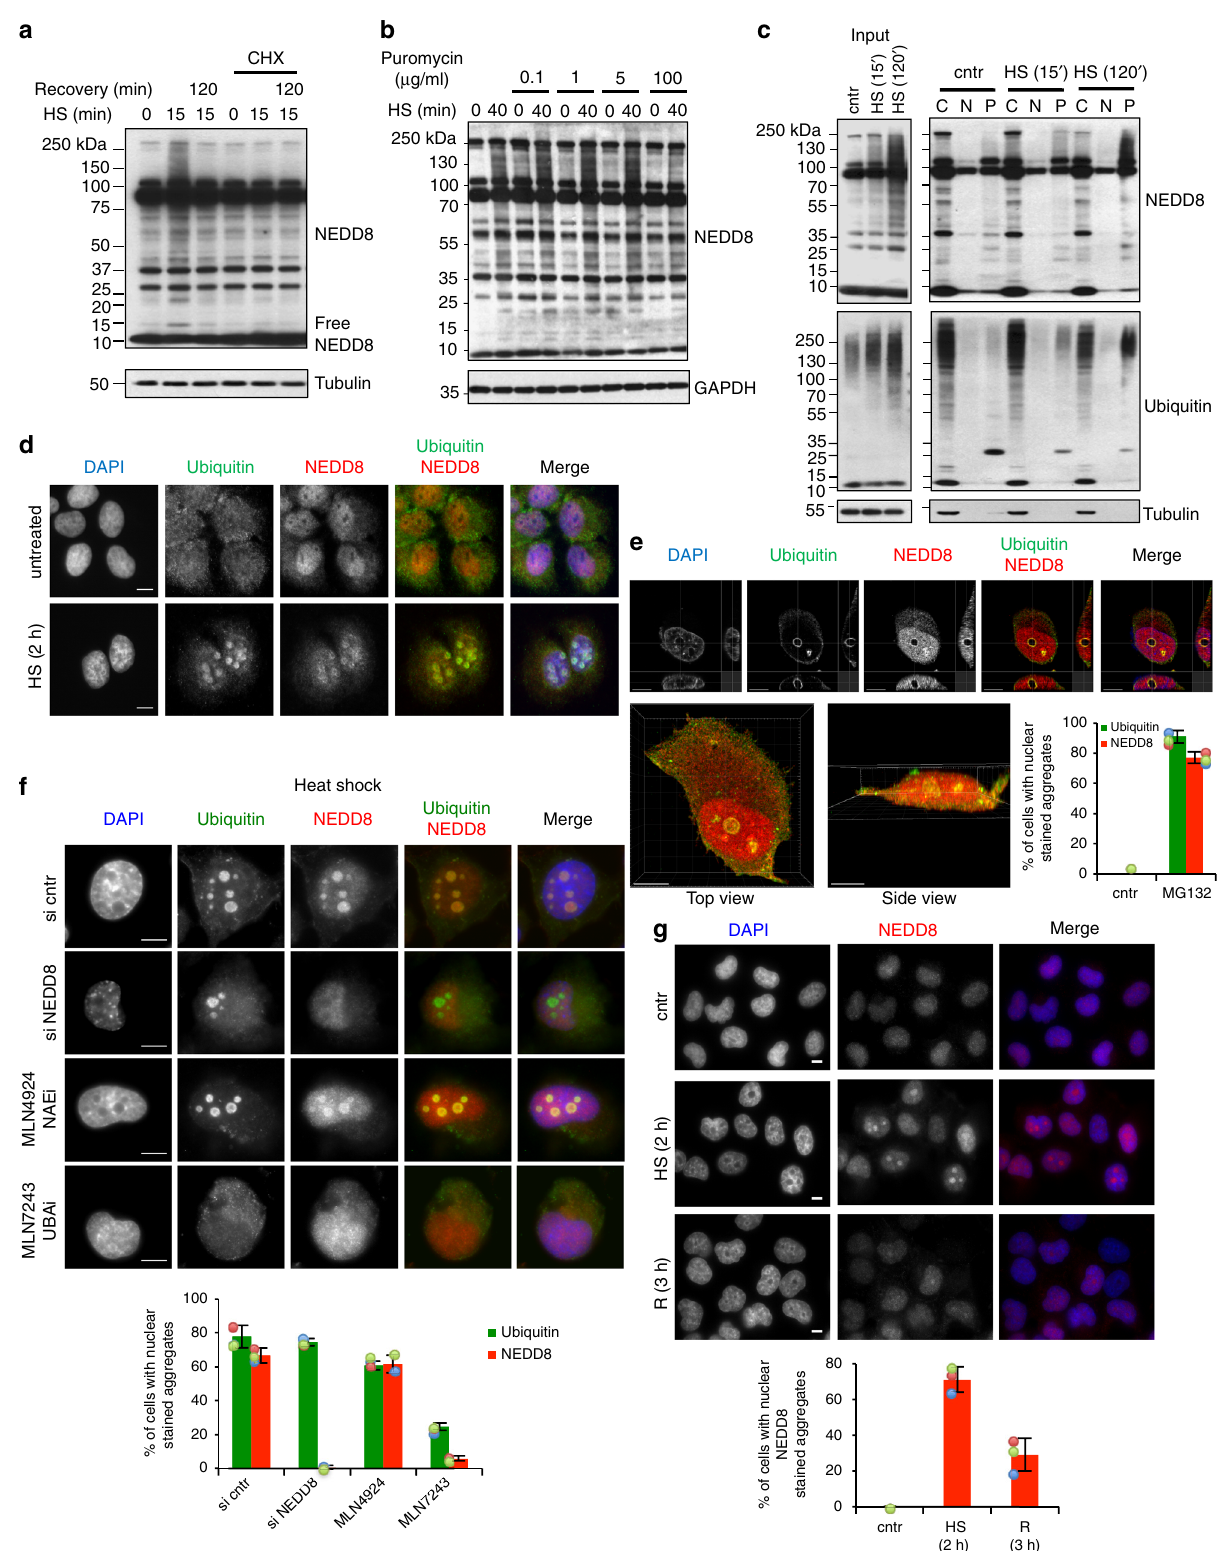
Figure 2C). The combination of the above data indicates that HS induces a progressive accumulation of transient and reversible NEDD8 protein aggregates in the nucleus through NEDD8 activation by